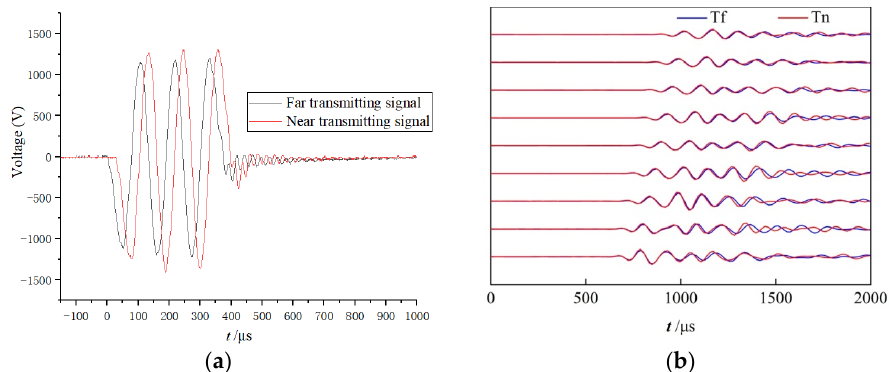
Figure 6. Schematic diagram of the dual ‐ source excitation circuit.